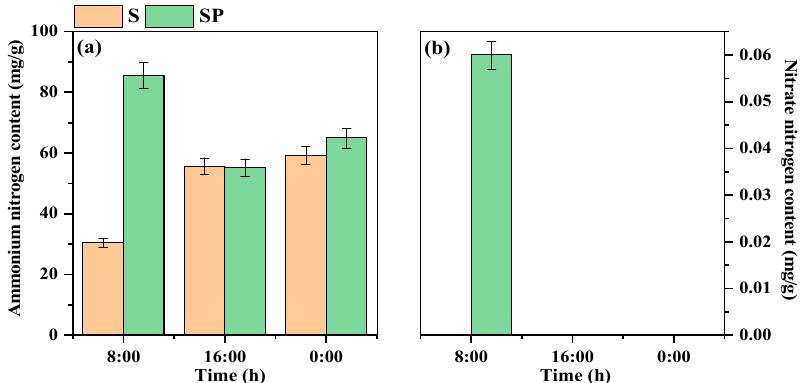
Figure 5. Diurnal variation of ammonium nitrogen and nitrate nitrogen contents in the sediment of the agricultural drainage ditch. ( a ) content of ammonium nitrogen in sediment; ( b ) content of nitrate nitrogen in sediment.